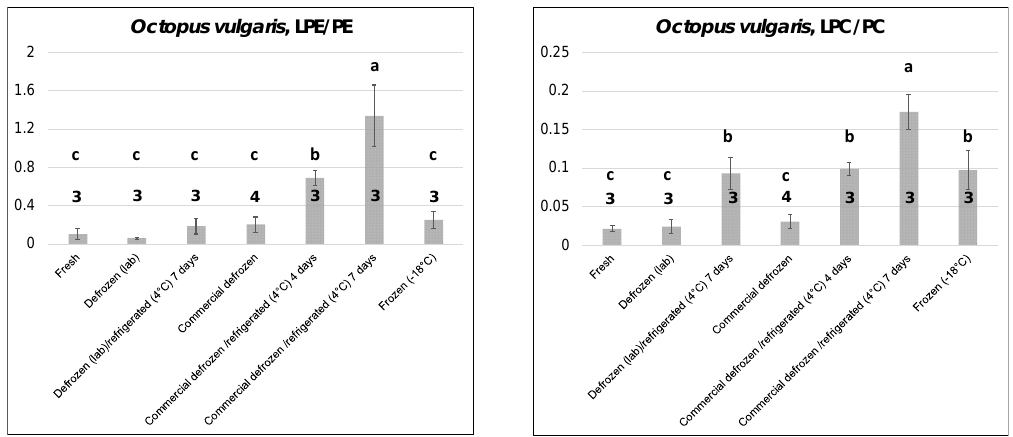
Figure 4. Comparison between LPE/PE and LPC/PC ratios of ESI(+)-FTMS responses obtained from the HILIC–ESI(+)-FTMS analysis of lipid extracts of common octopuses ( O. vulgaris ) that were subjected to lipid extraction soon after purchase or capture (fresh), as defrozen (either in lab or commercially), frozen or defrozen/refrigerated product. Mean values and standard deviations (error bars) that are plotted relate to the number of replicates indicated for each type of sample. The results of a Tukey–Kramer test are reported in the form of sample-type grouping and emphasized by letters. See text for details on the calculation of the LPE/PE and LPC/PC ratios from XIC chromatograms and on the different thermal treatments.